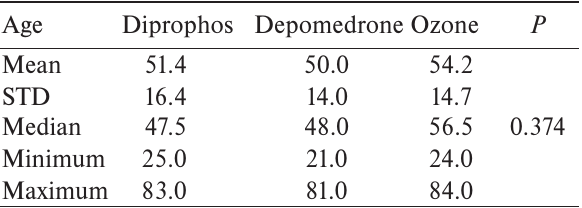
Table 1. Age characteristics of individual